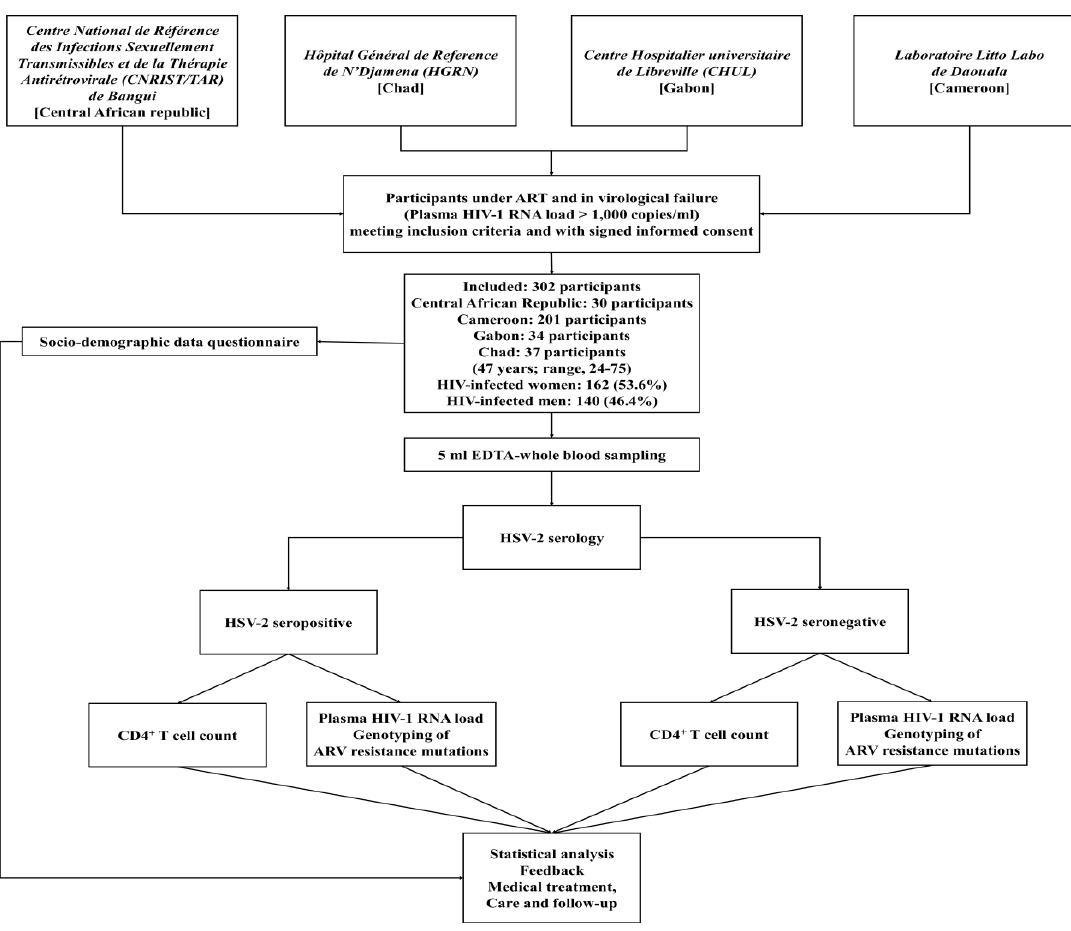
Figure 1. Flow-chart of the selection procedure of the study participants and inclusion sites.